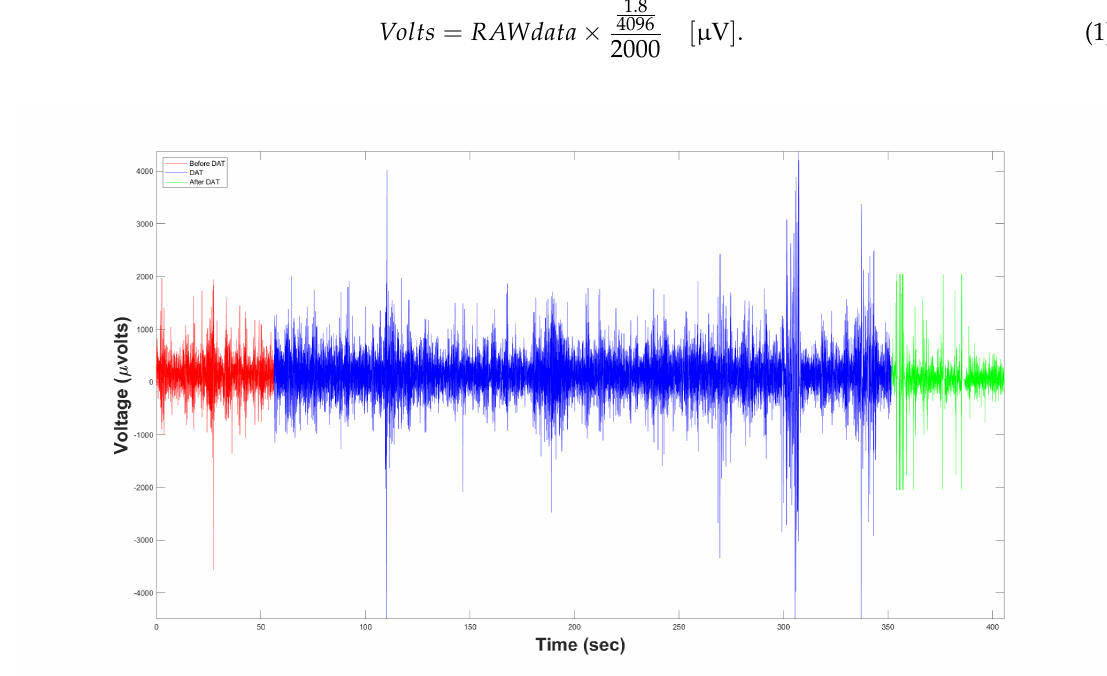
Figure 5. Representation of the RAW data in µ